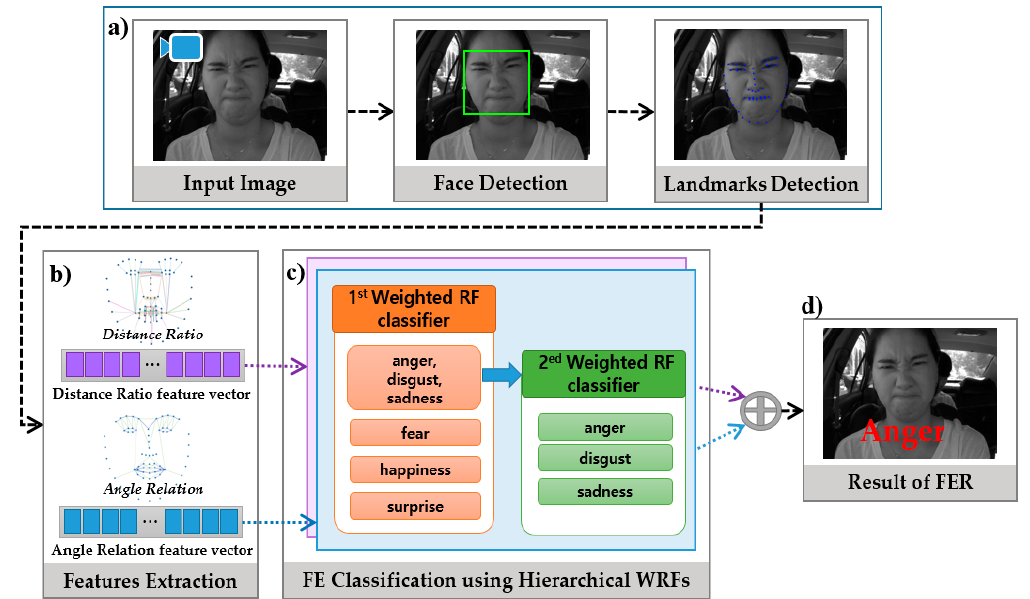
Figure 1. Overview of the proposed method for facial expression recognition. ( a ) the face region and facial landmarks are extracted from the image; ( b ) two geometric features are extracted based on the distance ratio and angle relations; ( c ) the hierarchical weighted random forest classifies the facial expression ( d ).